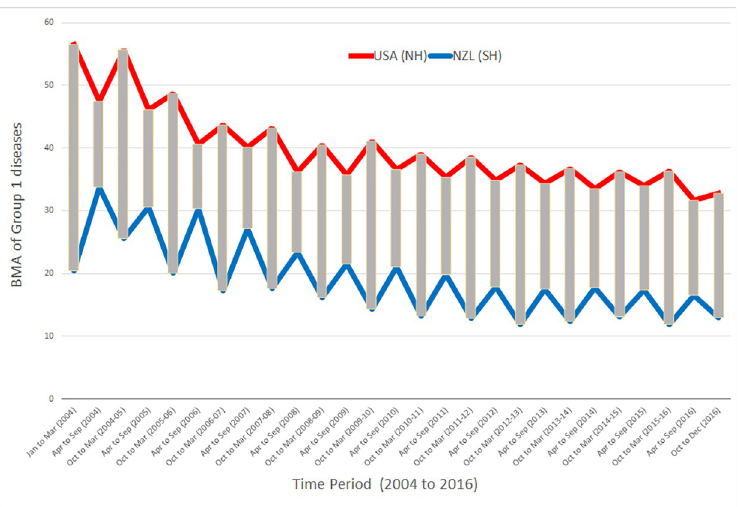
Fig 12. Season wise BMA of group 1 diseases for USA (Red in color) and NZL (Blue in color). The X-axis time period (2004–2016) of each year divided into the window size of 6 months and labelled as April (APR) to September (SEP) and October (OCT) to March (MAR). The Y-axis marked with BMA of Group 1 diseases for the 6 months window size. Please note that USA and NZL seasonal search patterns were juxtaposed (vertical gray bars).